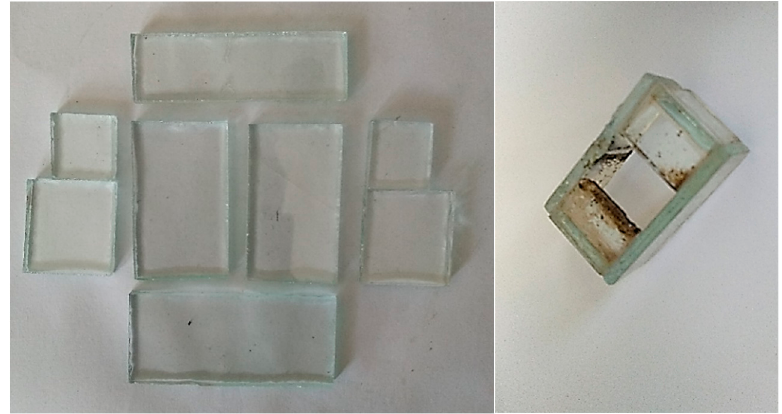
Figure 3. Isolating glass box.